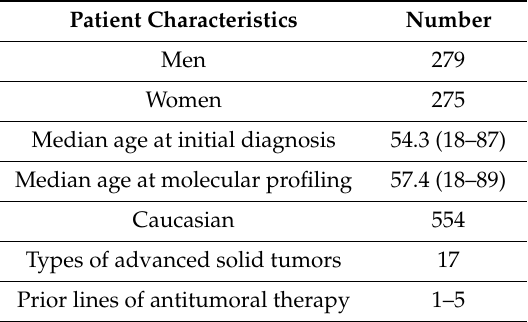
Table 1. Patient characteristics (N = 554).